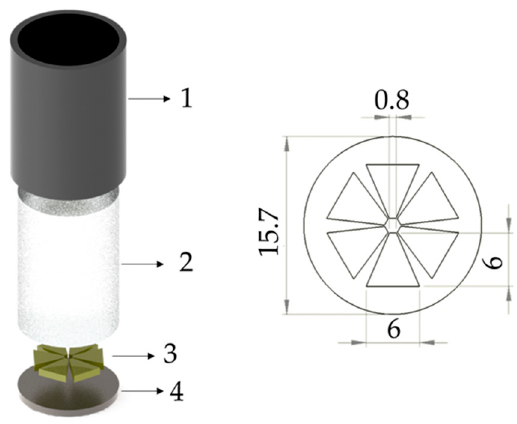
Figure 2. Schematic of the omnidirectional piezoelectric transducer assembly. The component description: